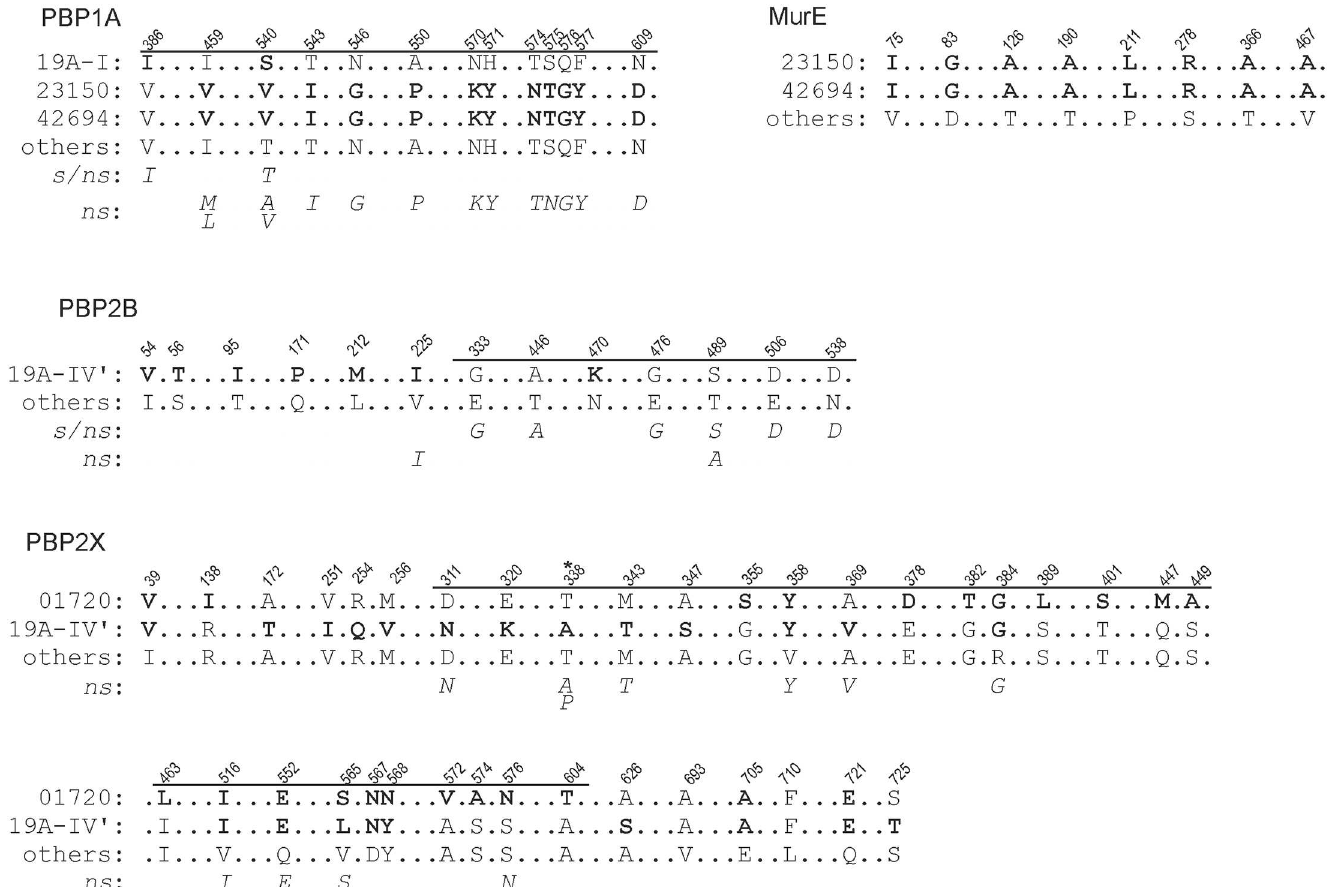
Fig 4. Amino acid substitutions identified in the PBPs (1A, 2B and 2X) and MurE of the ST199 isolates in this study (bold letters) and of other isolates published elsewhere (italic letters). ‘Others’ indicatesthe protein sequenceof all merged isolates of this study, except for those indicatedby their ID. The nonsusceptibility bases on the epidemiologicalcut-off (ECOFF) > 0.06 mg/L that indicatesthe breakpoint betweenthe susceptible( s ) and nonsusceptible isolates ( ns ). The positionof the conservedmotif SXXK of the PBPs is indicatedby asterisks. The amino acid positions,as well as the TP- domainof the respectivePBPs shownas bars, are indicatedabove the sequences. Sequences publishedelsewhere(italic letters) refer to [35, 37, 41–44].